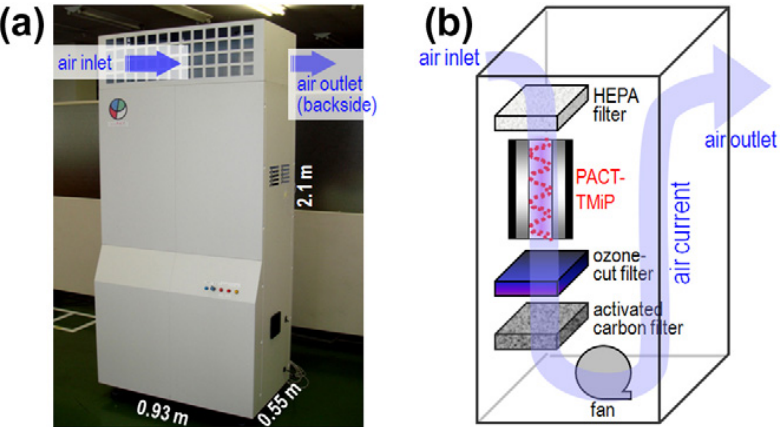
Figure 12. Device ( a ) and schematic construction ( b ) of an air purifier for cleaning air in smoking rooms. (Reprinted/adapted with permission from Ref.